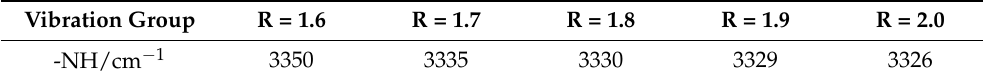
Figure 6. FT-IR spectra of SPU films with different R values. Table 1. Displacement of vibration peaks in bio-based polyurethane films with different R